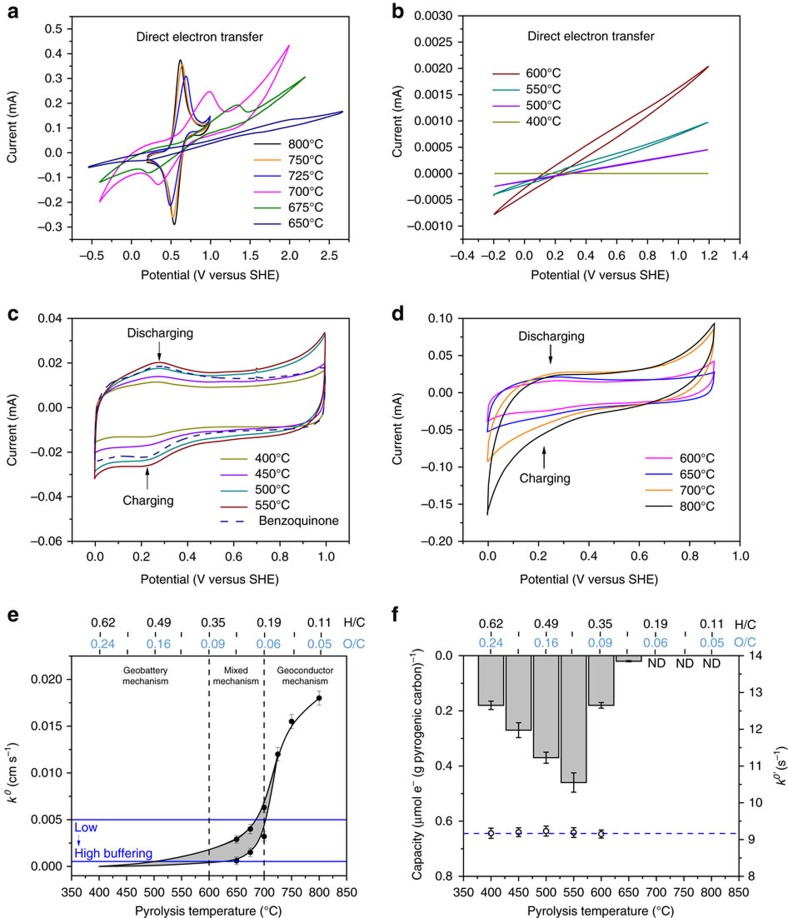
Direct electron transfer versus charging and discharging.(a,b) Direct electron transfer. Cyclic voltammograms of (dimethylaminomethyl)ferrocene (3 mM) in 0.1 M KCl (pH=7) at the pyrogenic carbon working electrodes. A formal potential of 0.59 V versus standard hydrogen electrode (SHE) was obtained for (dimethylaminomethyl)ferrocene. Scan rate=150 mV s−1 for pyrogenic carbons produced at 800–675 °C and 50 mV s−1 for pyrogenic carbon produced at 650–400 °C. (c,d) Charging and discharging cycles. Cyclic voltammograms of immobilized surface functional groups (carried by 0.12 mg pyrogenic carbon pyrolysed at temperatures 400–800 °C) at a graphite working electrode. Dashed line indicates the cyclic voltammogram of immobilized benzoquinone (0.03 mg on graphite electrode). Scan rate=100 mV s−1. (e) Direct electron transfer rate constant (k0) of pyrogenic carbon matrices. Blue lines are the k0 of benzoquinone measured at low- to high-buffered conditions (pH=7). (f) Estimated charging and discharging capacity (column) and rate constant (k0′) of surface quinone groups (open circles) and benzoquinone (blue dashed line). ND denotes not detectable. The corresponding molar H/C and O/C ratios are given above the top x axes of e,f. Error bars are s.d. of triplicate measurements.